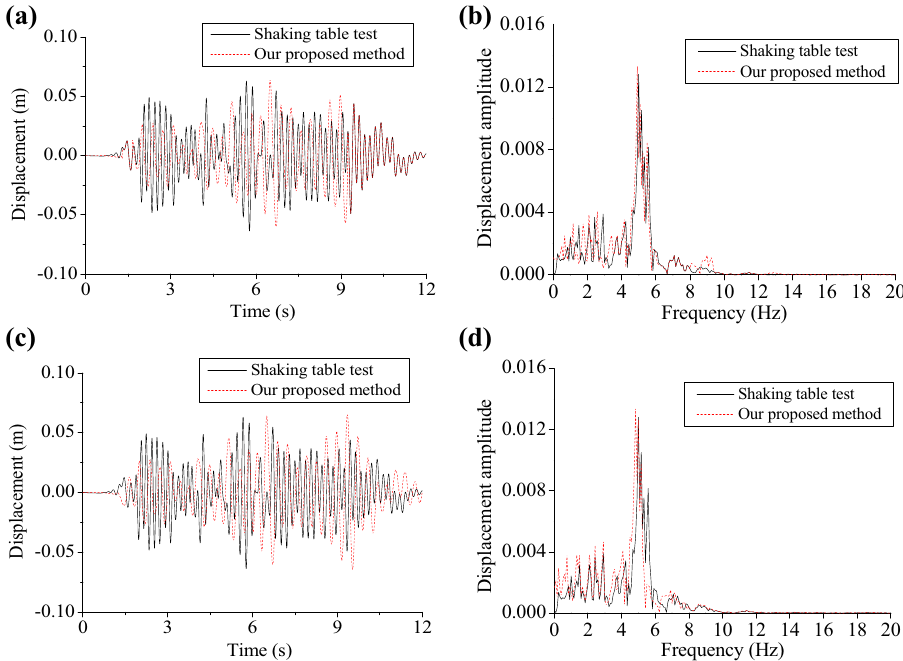
Figure 11. Time histories and Fourier spectra for displacement in the presence and absence of ice influences: ( a ) displacement influenced by ice; ( b ) Fourier spectrum influenced by ice; ( c ) displacement without ice influence; ( d ) Fourier spectrum without ice influence.